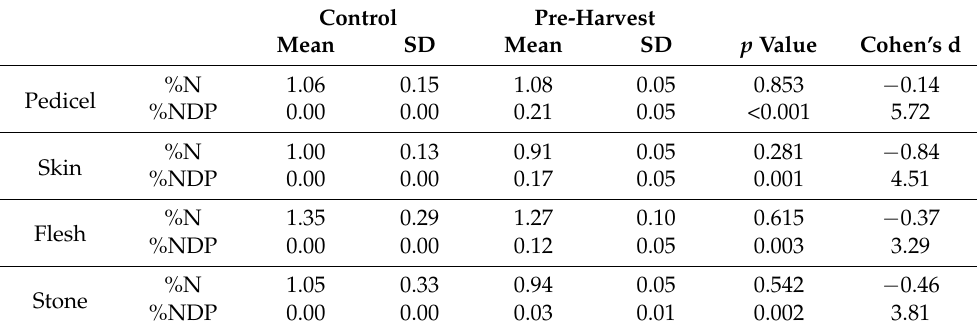
Table 2. Total N content (%N) and N derived from L-proline (%NDP) of fruit tissues at commercial harvest arising from trees from control and pre-harvest L-proline application (n = 4). Control Pre-Harvest Mean SD Mean SD Cohen’s d